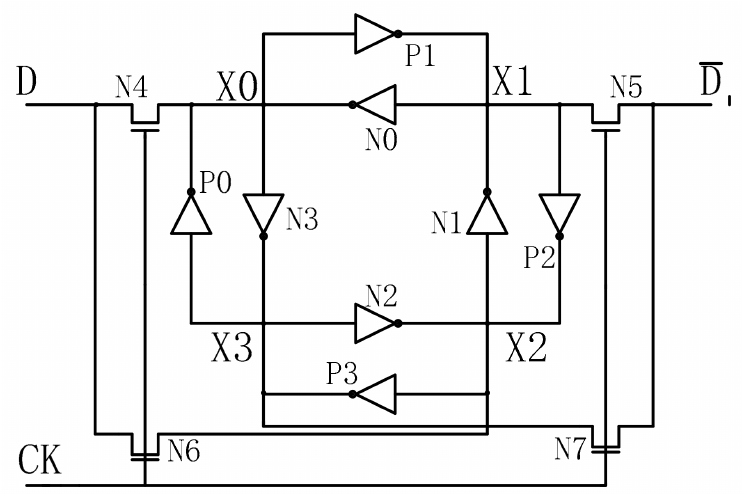
Figure 1. DICE (Dual Interlocked Storage Cell) schematic.